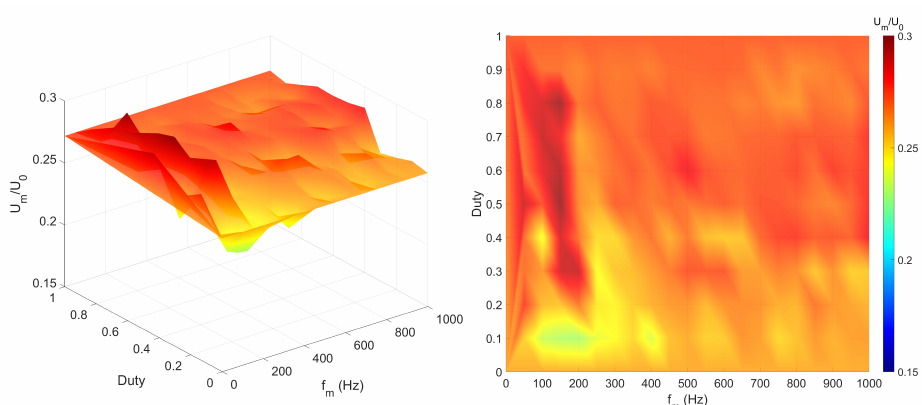
Figure 11. Velocity profiles along the y and z axes at different locations.